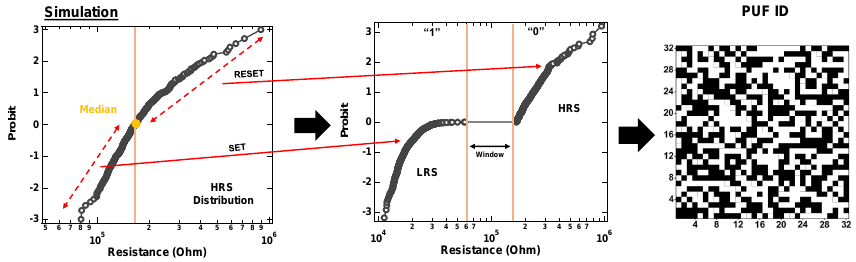
Figure 5: The implementation method using the HRS variation with the split procedure. The threshold for the split procedure is also defined as the median resistance (150